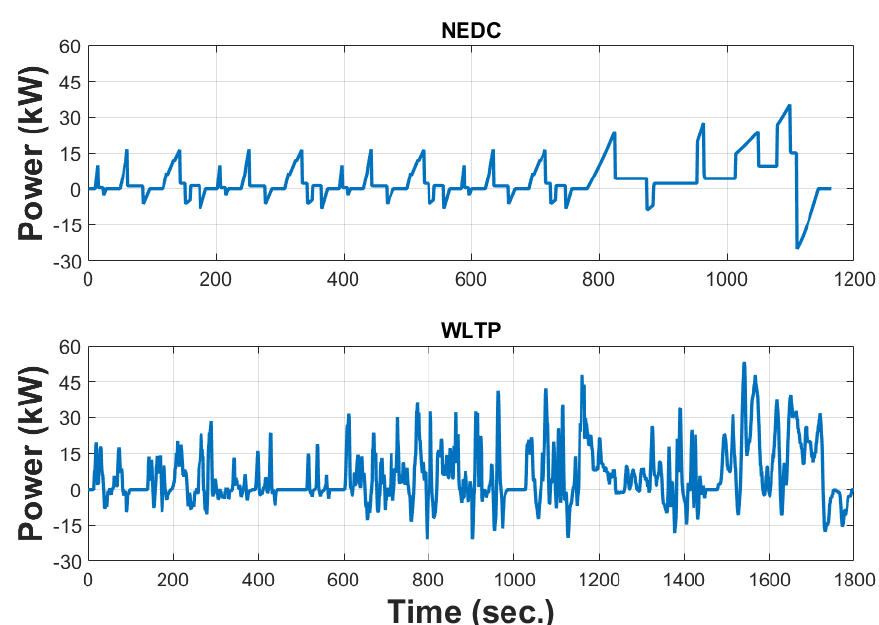
Figure 12. Electric power required by SFUDS (top) and FUDS (bottom).